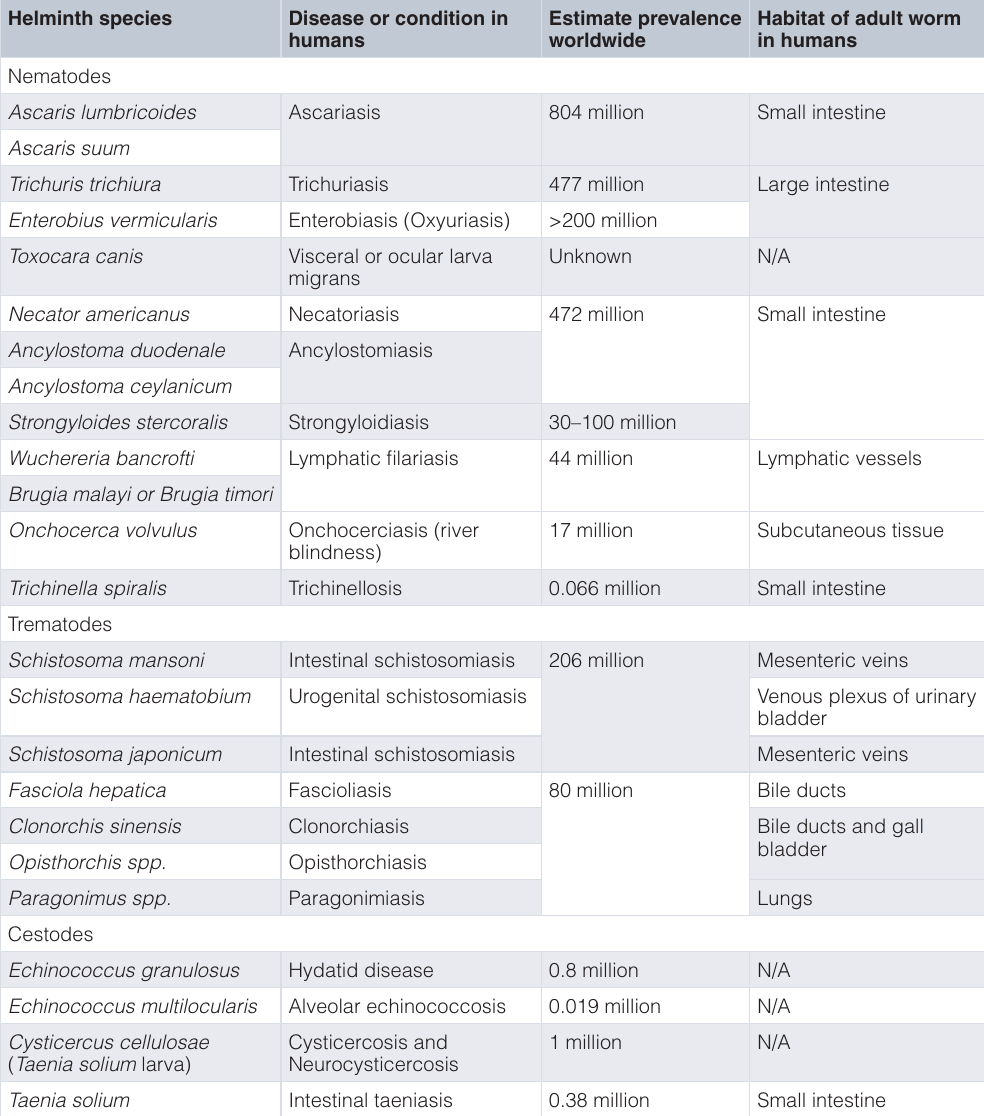
Table 1. Human helminth infections of public health